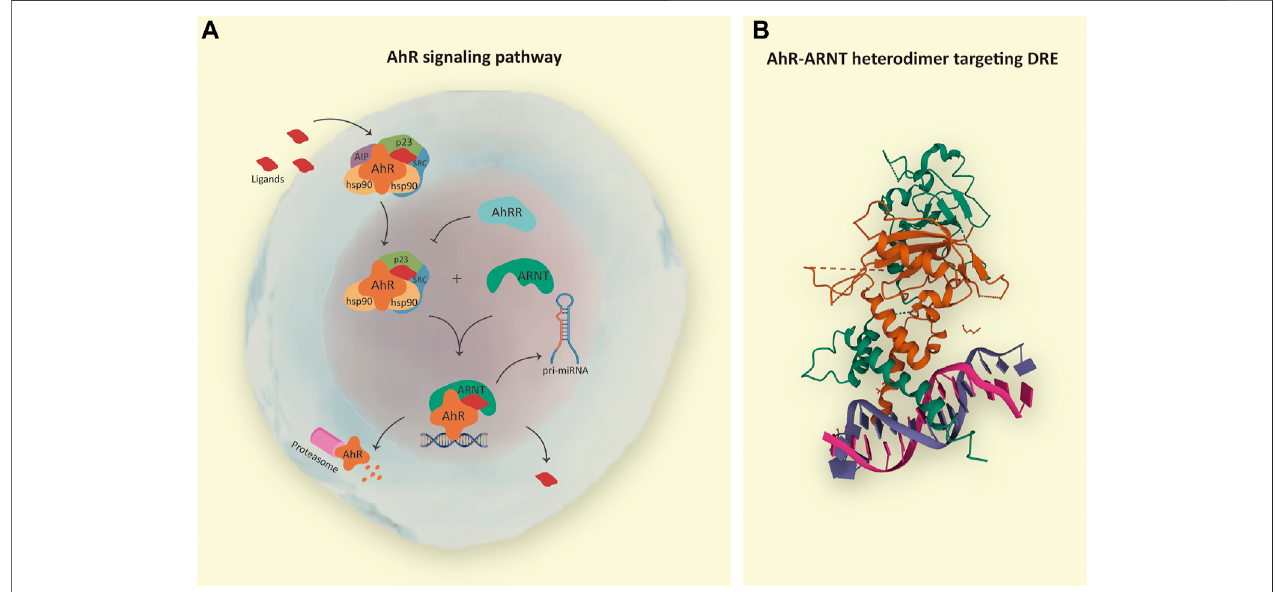
FIGURE 1 | (A) AhR signaling pathway. The inactive form of AhR is localized in the cytosol complexed with chaperones: HSP90, AIP, p23, and SRC. Endogenous orexogenousAhRligandsenterthecellandinduceconformationalchangesinAhRcomplex,resultinginAIPreleaseandproteincomplextranslocationtothenucleusin a transportin and importin- β -dependent manner. In the nucleus, AhR interacts with ARNT, and the heterodimer is responsible for the transcription of genes containing dioxin response elements (DRE), such as pri-microRNAs; whereas AhRR acts as a negativeregulatory mechanism. After transcriptional regulation, the